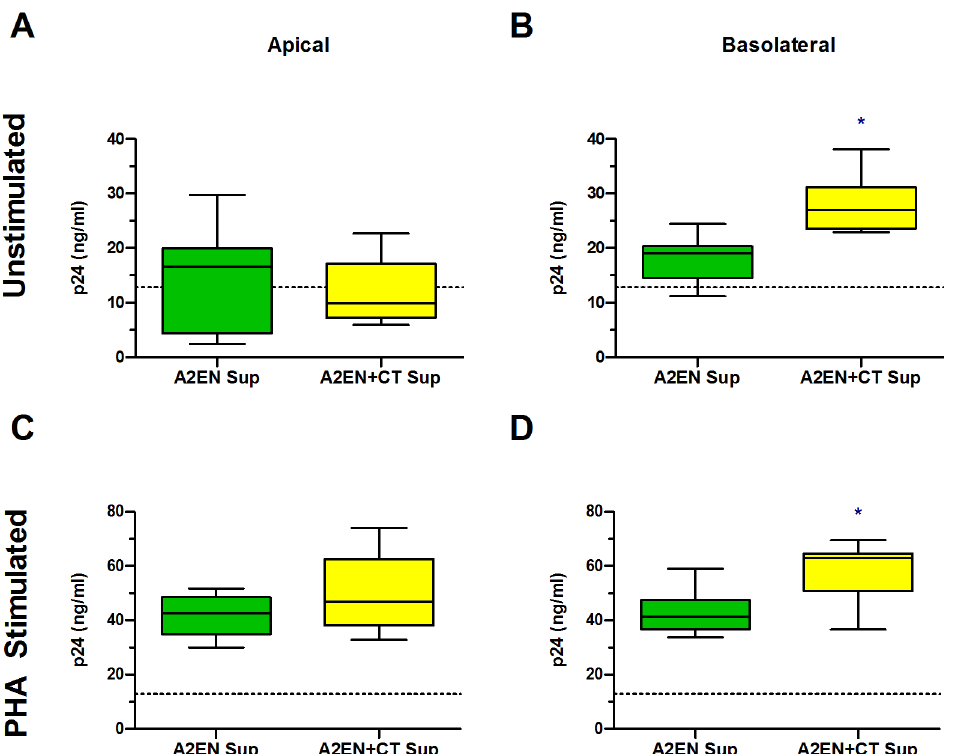
Fig 6. Basolateral supernatants from CT-infected A2EN cells enhance HIV infection of PBMC. A2EN cells grown on cell culture inserts were infected with CT serovar D for 72 h. ( A, C ) Apical and ( B, D ) basolateral supernatants collected from mock or CT-infected A2EN cells were incubated with ( A, B ) resting PBMC for 4 d or ( C, D ) PHA-activated PBMC for 2 d. The PBMC were then infected with 200 TCID 50 of HIV BAL . Activated PBMC were additionally cultured with A2EN supernatants for another 2 d after infection. Every 2 d after infection, the culture medium was completely replaced. The viral content in culture medium collected 6 d after infection was determined using a p24 ELISA. Presented are the cumulative p24 results from 3 separate experiments, each performed in triplicate. Bars represent the mean ± SD. * p < 0.05.